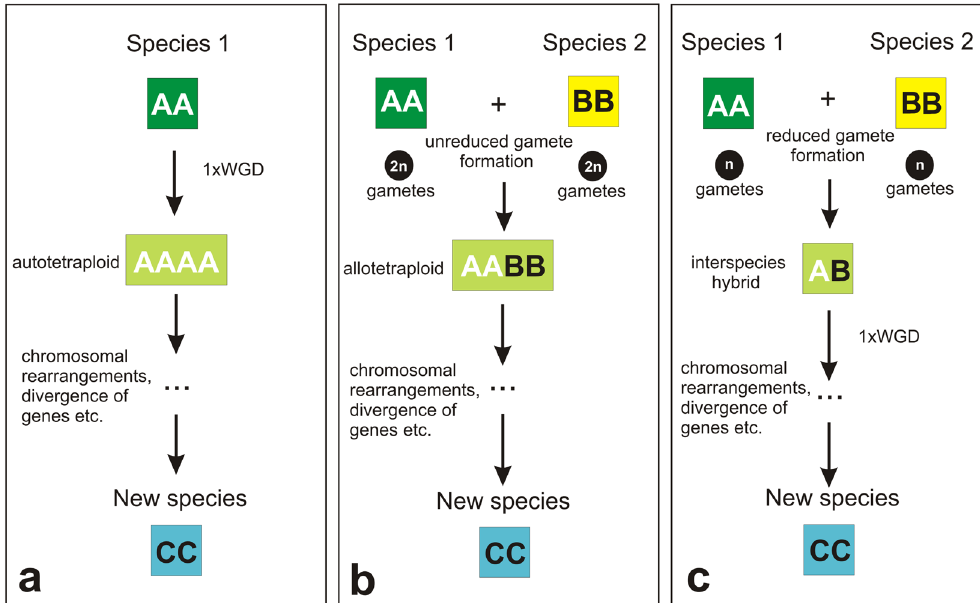
Figure 3. Possible scenarios for autoploid ( a ) and allopolyploid ( b , c ) formation of the M. lignano genome. ( a ) Autotetraploid (2n = AAAA) formation from a diploid species (2n = AA); ( b ) Hybrids (2n = AABB) formed from crosses between two closely related diploid species 1 (2n = AA) and 2 (2n = BB) with polyploidy through unreduced gamete formation, ( c ) Hybrids (2n = AB) formed from hybridization between species 1 (2n = AA) and 2 (2n = BB) without polyploidy, but followed by one